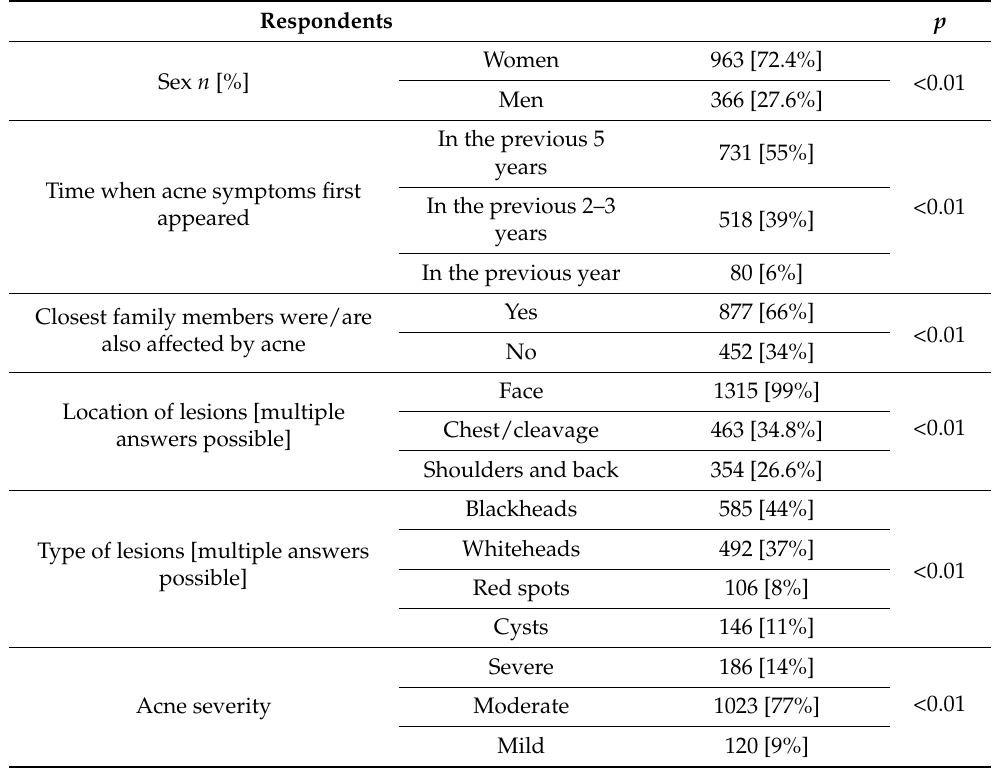
Table 1. Characteristics of the study